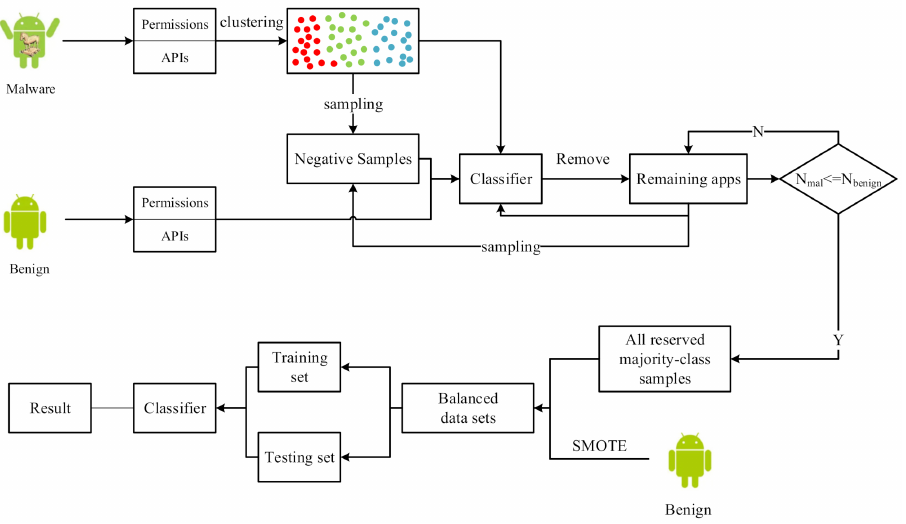
Figure 1. The architecture of